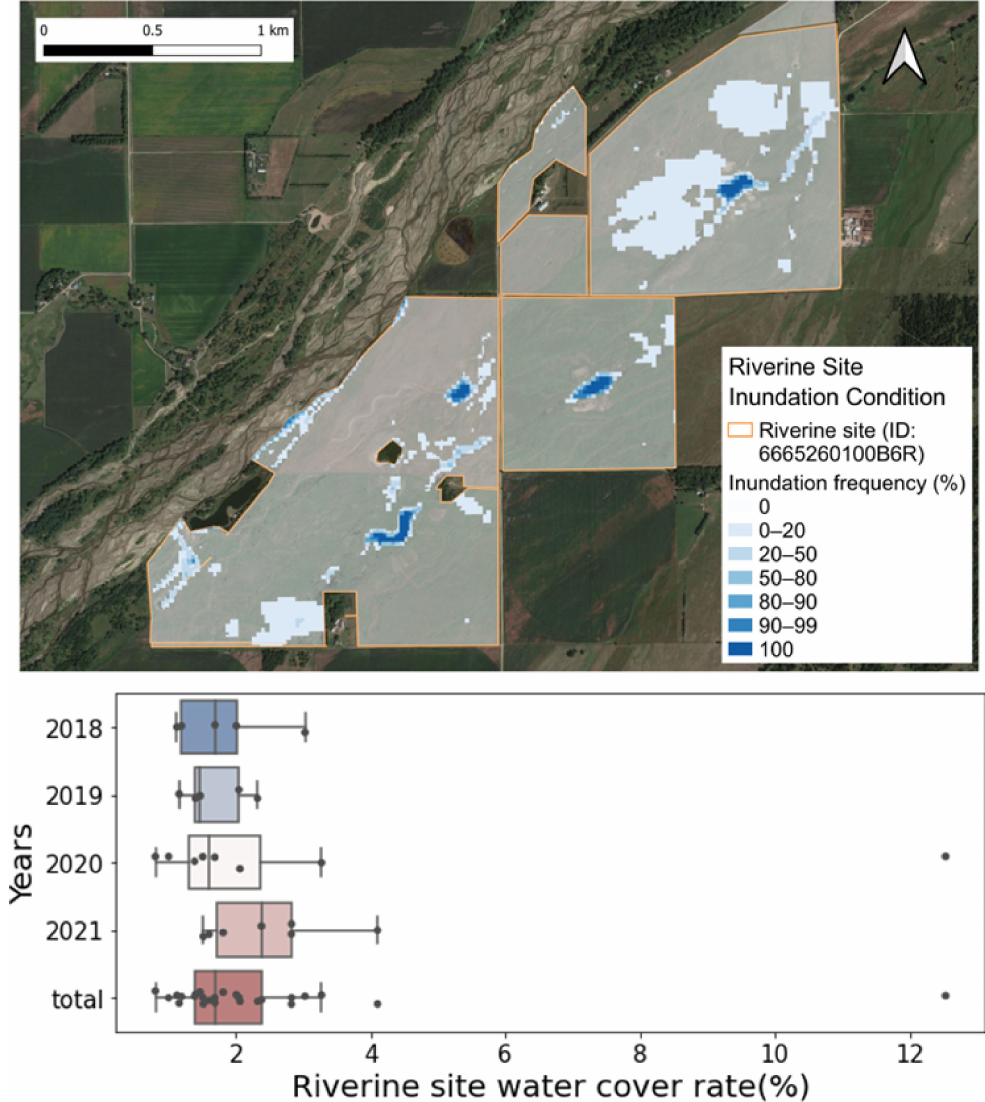
Figure 9. Inundation frequency and surface water cover rate in the riverine